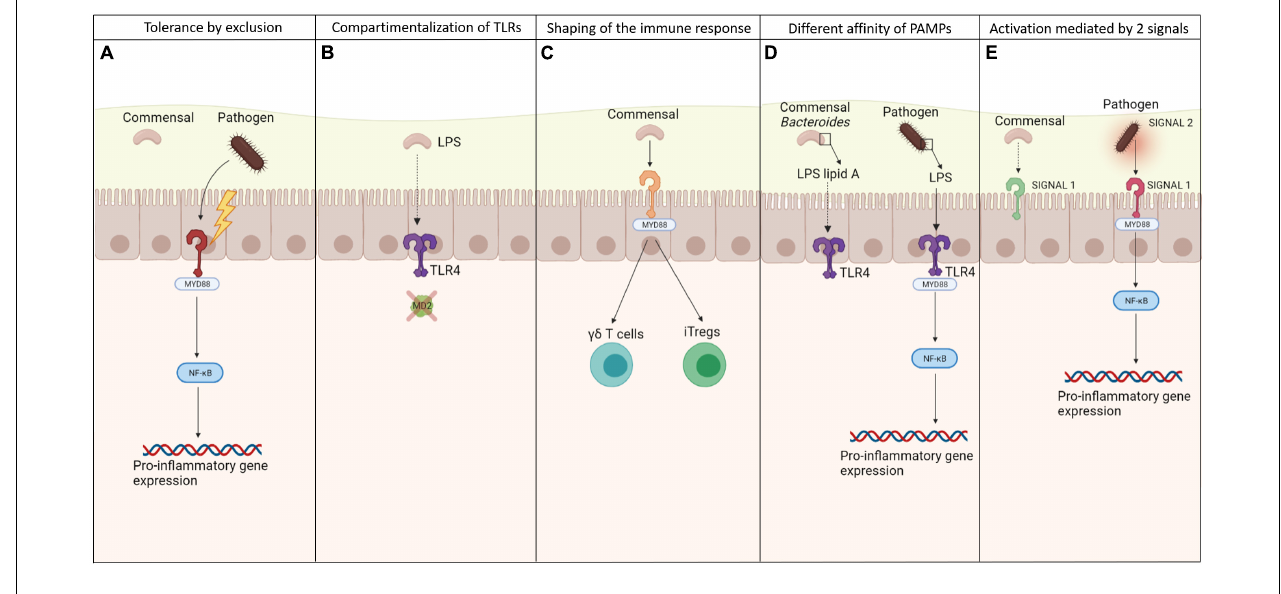
FIGURE 1 | Mechanisms of discrimination between commensals and pathogens by TLRs. Different mechanisms exploited by TLRs to discriminate between pathogenic and commensal microbes to keep the tolerance toward the local microbiota, preventing from inflammation: (A) more virulence possessed by pathogens, allowing them to destroy the epithelial barriers and set off an inflammatory state, after being recognized by TLRs; (B) specific compartmentalization of some TLRs and their co-receptors, allowing the recognition of bacterial signals only whether they are able to cross the epithelia; (C) the ability of commensals in shaping the immune system, maintaining the low inflammation rate and a balance between effector and suppressive cells; (D) the different affinity of PAMPs to TLRs so that they are able to recognize only the one relative to pathogens; (E) the need of 2 signals to activate an immune response, which come mainly from pathogens causing stress.